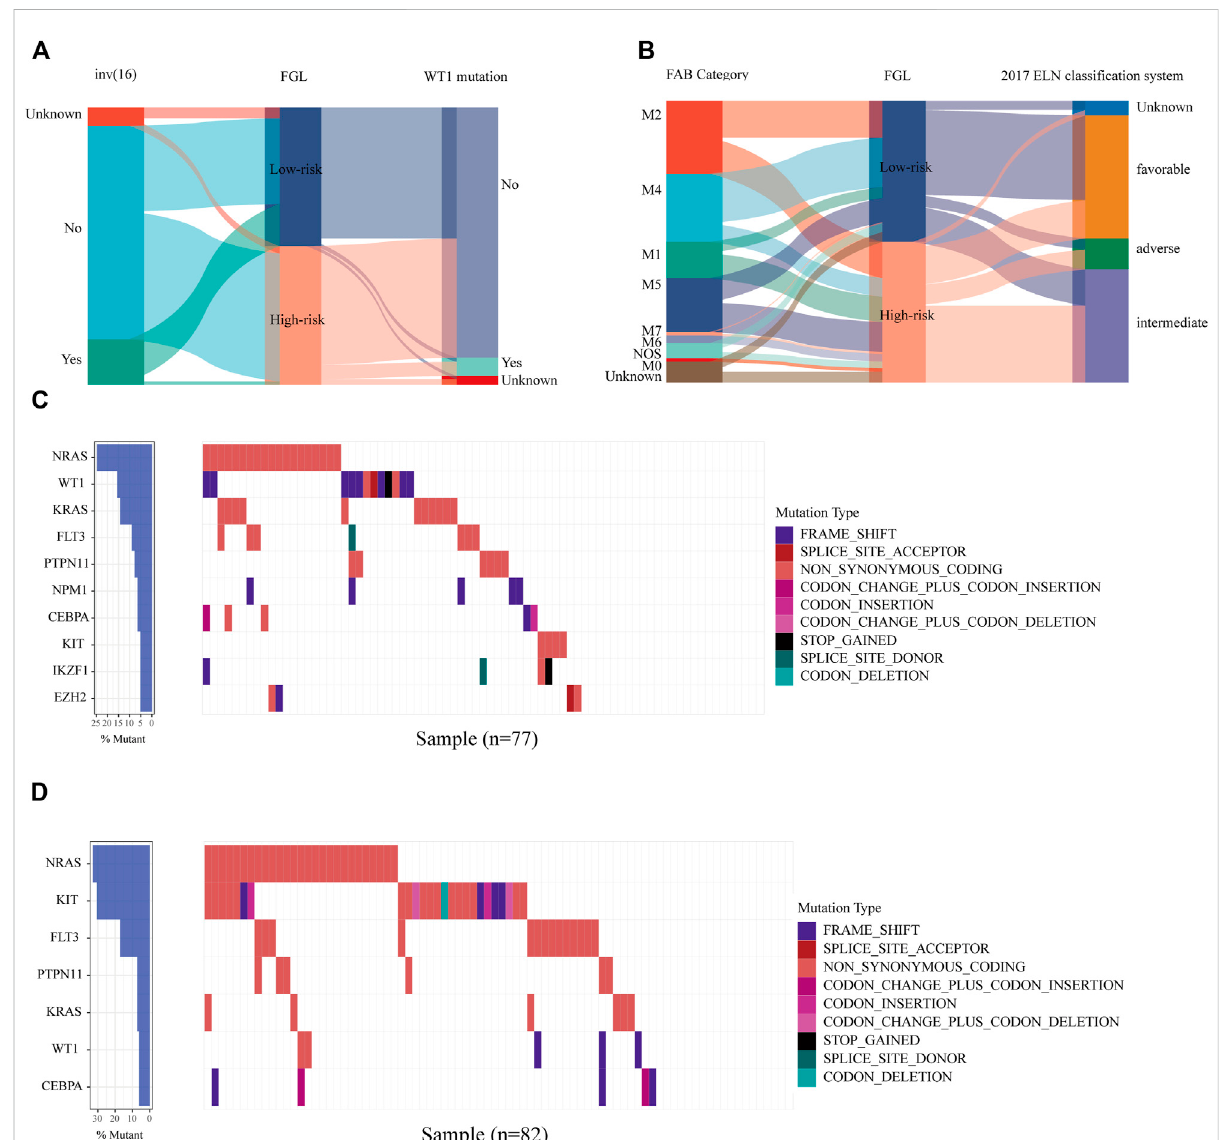
FIGURE 6 Relationship between clinicopathological and molecular characteristics and the ferroptosis-related signature. Sankey diagram describing the relative fl ow of subgroups of (A) inv (16) mutation, WT1 mutation, (B) FAB category, and 2017 ELN classi fi cation system according to the FGL risk group. Comparison of the mutation landscape between groups with (C) high and (D) low FGL risk